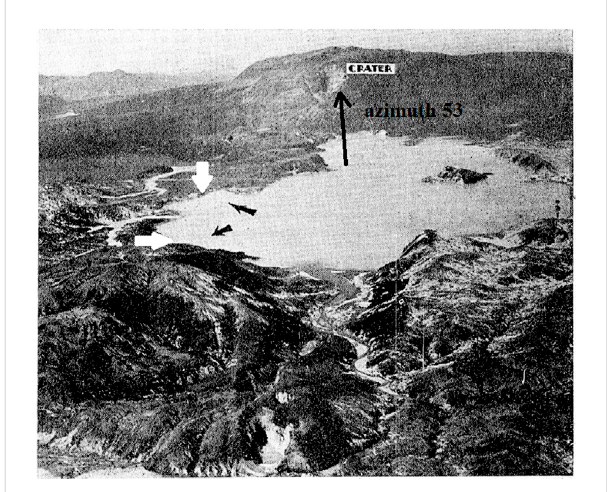
FIGURE 14 A c. 1936 aerial photograph of Lake Rotomahana, taken from the southwest. Warbrick ’ s 1936 black arrows point to his shoreline locations of the Terraces: the Pink Terraces in the second small bay below Boat Launch Bay and the White Terraces a little west of Tarata Peninsula. Based on Hochstetter ’ s survey, the white arrows point to our 2023 Terrace locations. The 1936 and 2023 arrows point to the same locations (New Zealand Herald, 16 May 1936, by